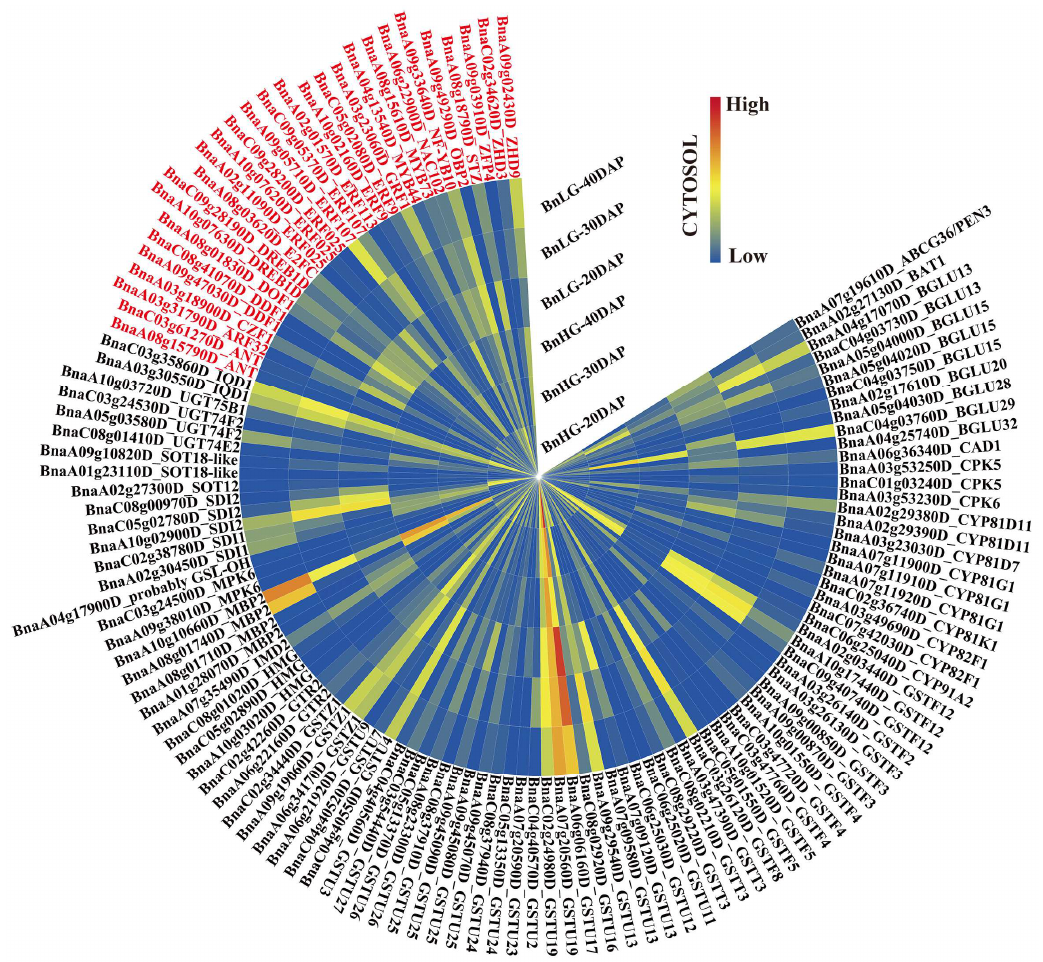
Figure 5. Expression patterns of the 123 novel candidate genes in B. napus . Genes shown in black are structural genes and those shown in red are transcription factor genes. The expression levels of these candidate genes in BnLG and BnHG are listed in Table S5. Further, 20, 30 and 40 DAP represent the seeds after 20, 30 and 40 days after pollination,